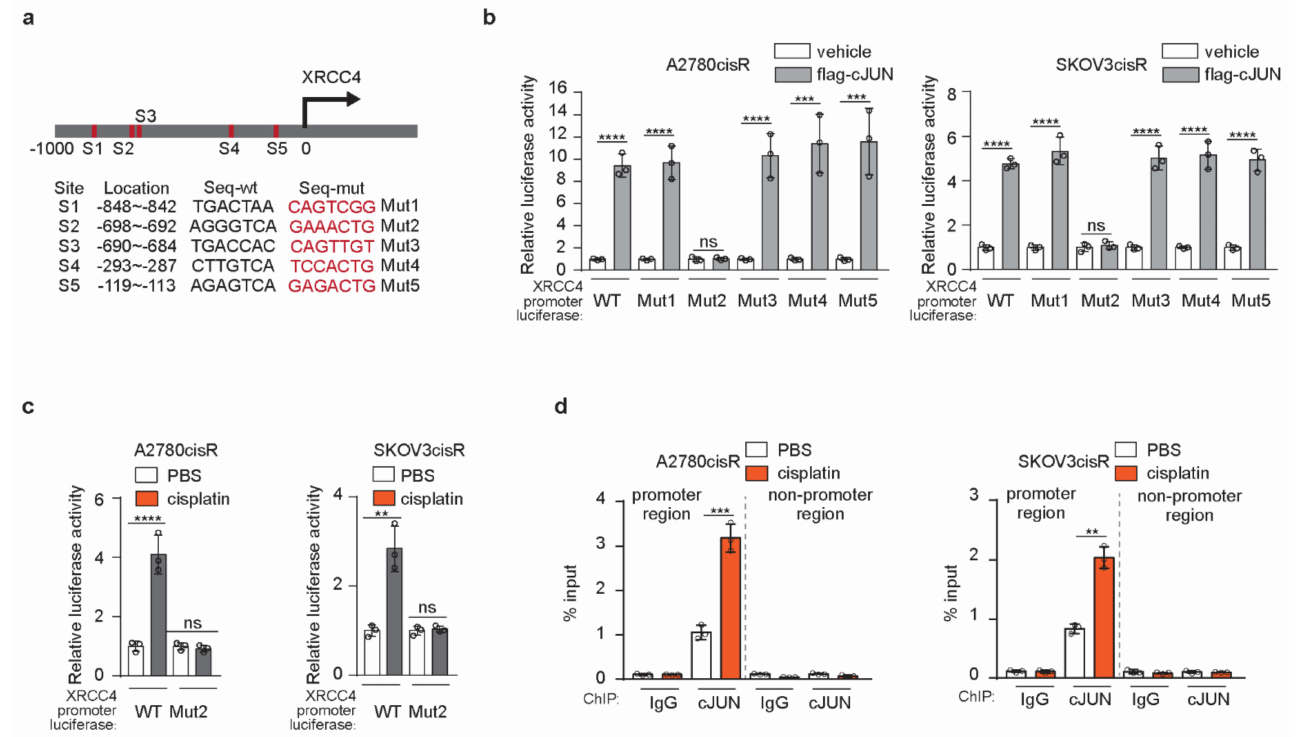
Figure 5. cJUN mediated the upregulation of XRCC4 in cisplatin-resistant ovarian cells treated with cisplatin ( a ) Schematic illustration of cJUN binding sites in the XRCC4 promoter. The wild-type (wt) and corresponding mutation sequences for each XRCC4 promoter-luciferase plasmids were